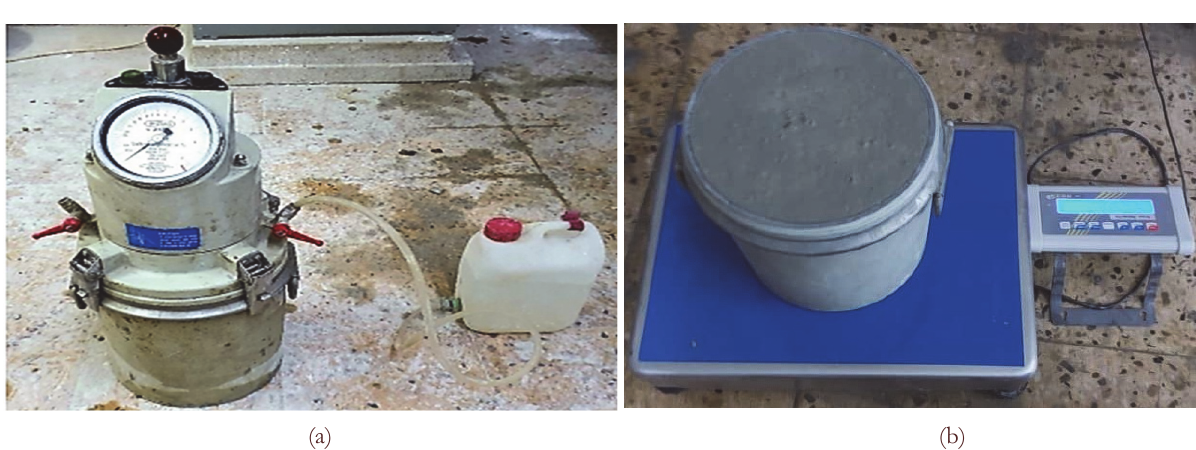
Figure 10: (a) determination of the entrained air with aerometer and (b) measure of concrete density in the fresh state.